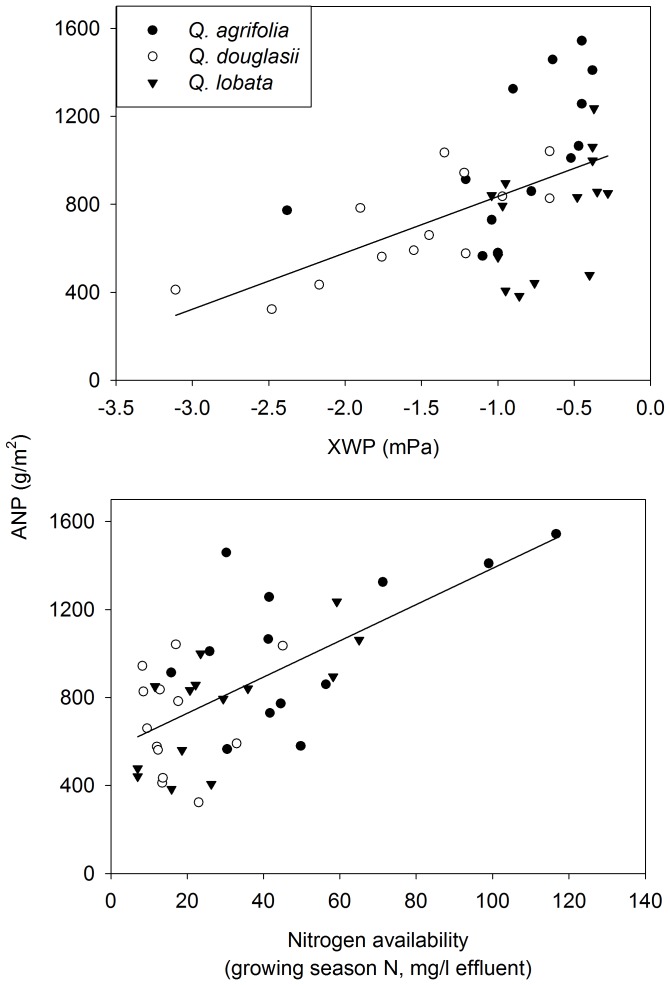
Five-year average (± SE) ANP of Quercus agrifolia (n = 13), Q. douglasii (n = 13 and Q. lobata (n = 14) in relation to XWP and resin bag extracted nitrogen.Lines are drawn for statistically significant relationships based on the GLM (Table 1).